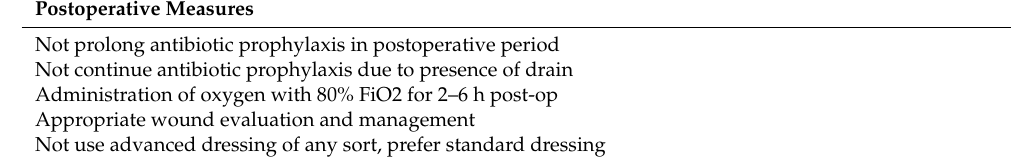
Abbreviations: SSI, surgical site